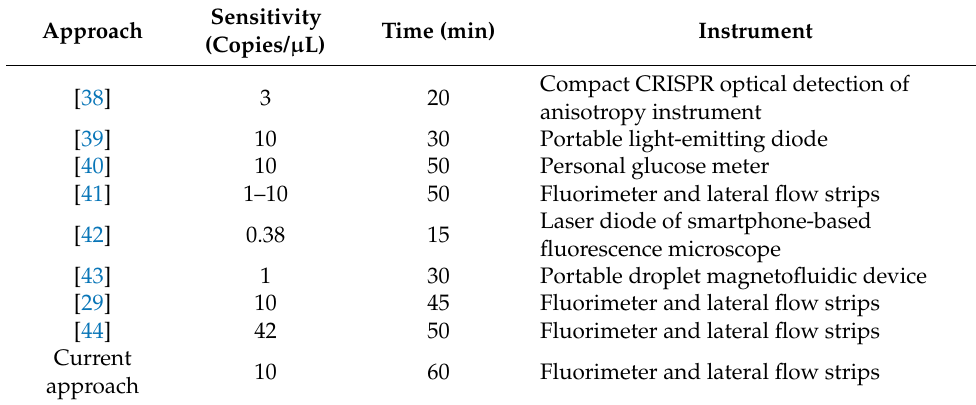
Table 1. Comparison of the current approach with previous SARS-CoV-2 detection